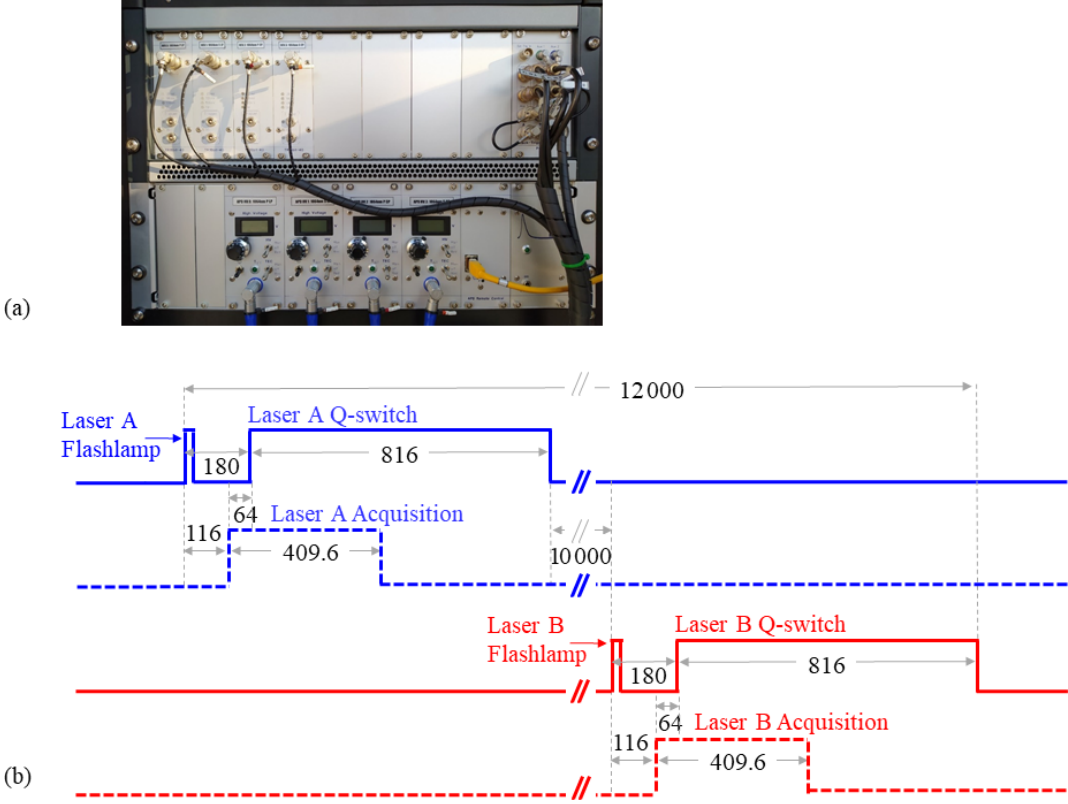
Figure 7. (a) The Licel rack with the TRs and the master trigger control unit. (b) The pulses from the master trigger control unit that synchronize the emission of the two lasers and the acquisition of the backscattered signals. The lengths of the pulses are in microseconds